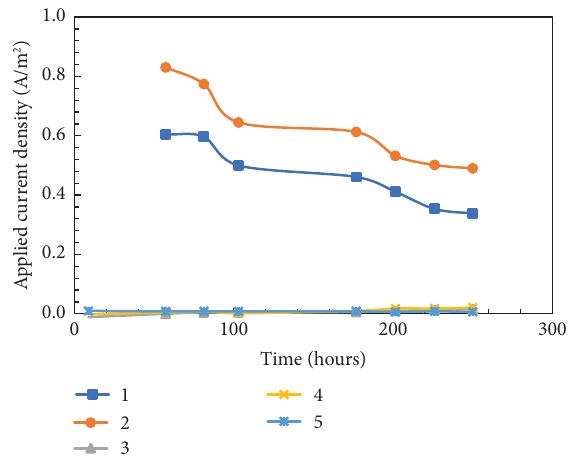
Figure 6: Te cathodic current density depending on the probe